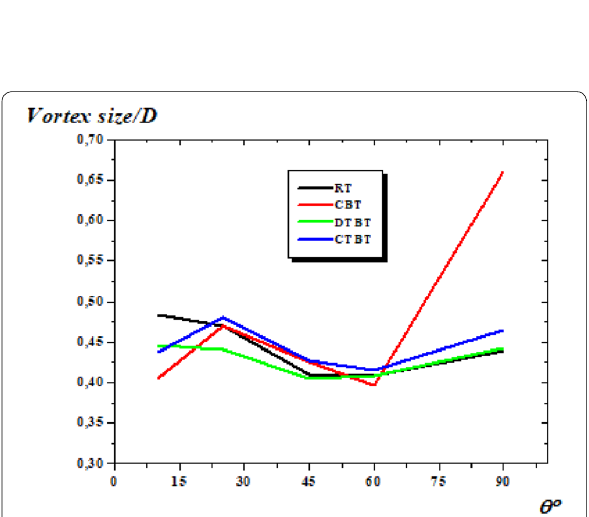
Figure 18 Vortex size for different agitator’s types with various impeller angles, Re